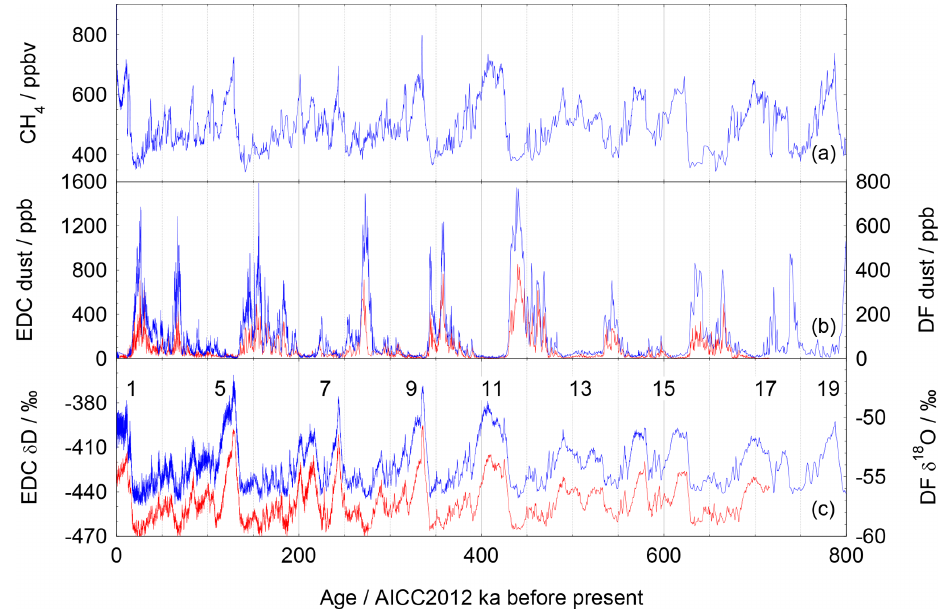
Figure 2. Ice core data over the past 800kyr. Ice core records covering the past 800kyr from Dome C (blue) and from the last 720kyr from Dome Fuji (red). (a) Methane (Loulergue et al., 2008); (b) dust (Kawamura et al., 2017; Lambert et al., 2008); (c) water isotopes (Jouzel et al., 2007; Kawamura et al., 2017), with interglacial marine isotope stage numbers